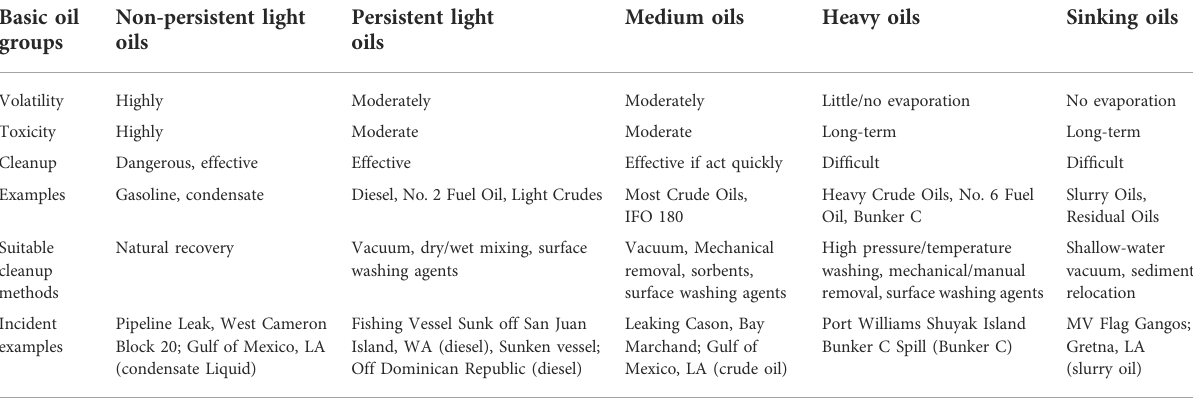
TABLE 1 The properties, oil examples, suitable shoreline cleanup response methods, and incidents examples of different oil